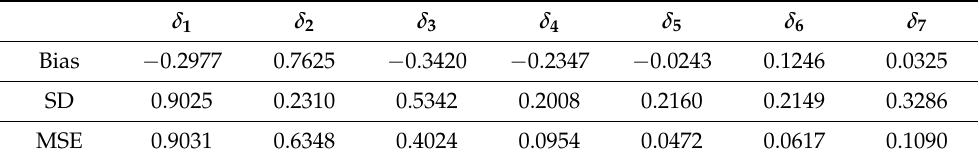
Table 9. Bias, SD and MSE evolutions with respect to the parameter δ variation for PLGSIMF with the logit link function and n = 500.